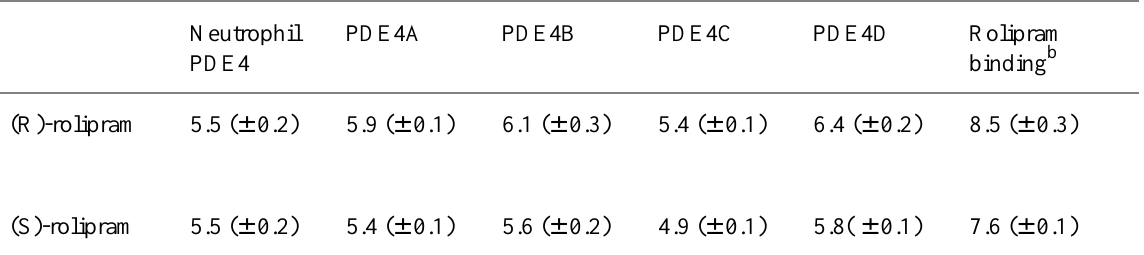
Table 2. Biological data for ( R )- and ( S )-rolipram.